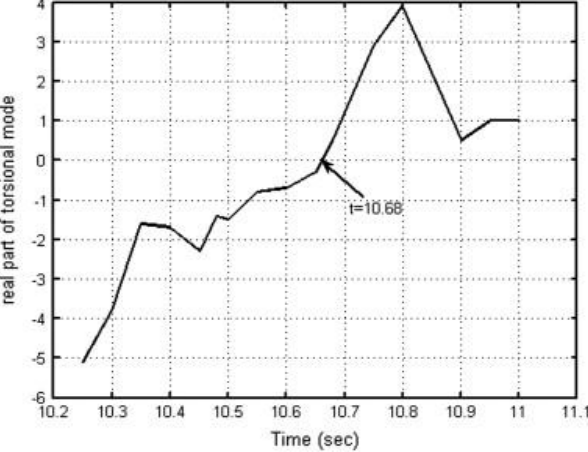
Figure 12. Fault clearing in the unstable case, with damping evolution of the critical oscillatory mode [56].